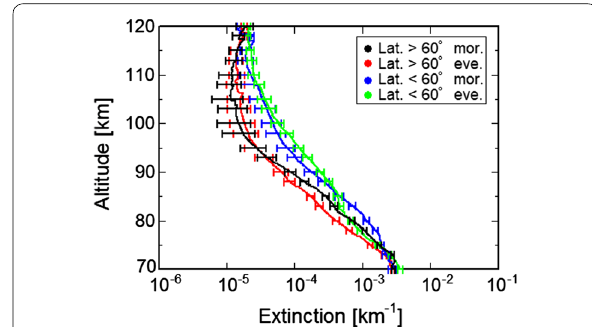
Fig. 7 Average of all normalized extinction coefficients for morning high‑latitude (latitude > 60 ◦ , black line), evening high‑latitude (latitude > 60 ◦ , red line), morning low‑latitude (latitude < 60 ◦ , blue line), and evening low‑latitude (latitude < 60 ◦ , green line) observations. The average of the variability is 34.3% for the morning high‑latitude